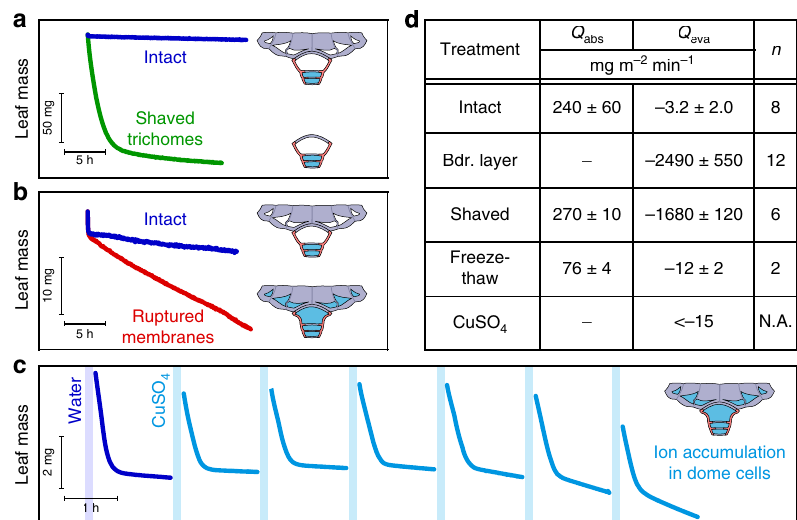
Fig. 4 Response of the trichome valve to various experimental disruptions. a Typical evaporation of a T. aeranthos leaf before and after shaving of the trichomes. The diagrams show the predicted state of the trichome during the evaporation phase. b Typical evaporation of a T. aeranthos leaf before and after freeze-thawing to rupture the plasma membranes of the foot cells. c Evaporation of a T. aeranthos leaf following successive 15-min immersions in a CuSO 4 solution (5 (cid:5) 10 (cid:2) 3 M). The fi rst steep slopes correspond to the rate of evaporation of the free liquid fi lm on the leaf surface immediately after immersion in liquid. d Summary table of the mean rate of absorption and evaporation under different treatments (mean ± std computed for a sample size of n